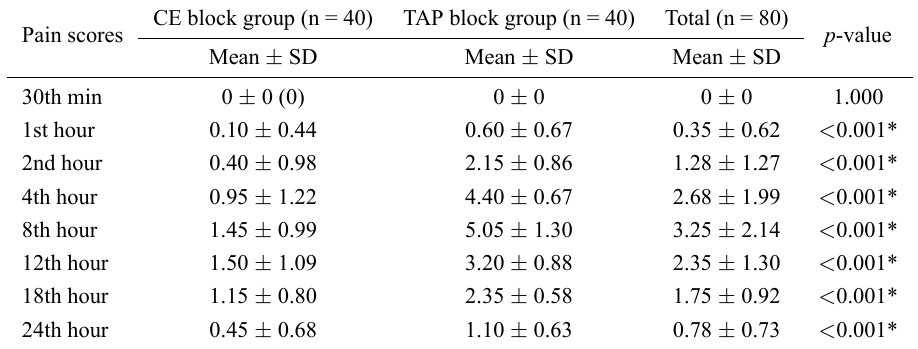
Table 2. Comparison of pain scores between groups.